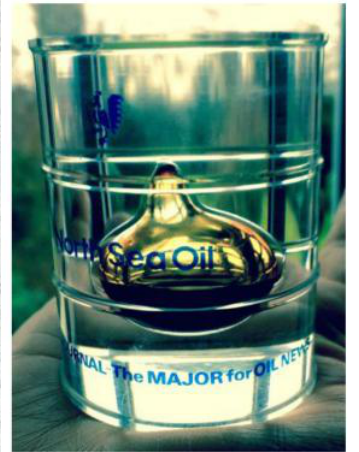
Figure 9. North Sea Oil paperweight.